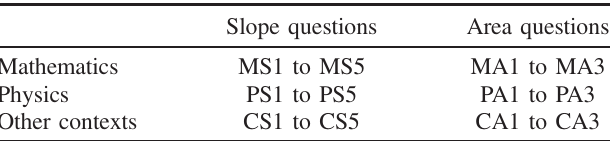
TABLE I. Labels of questions in the